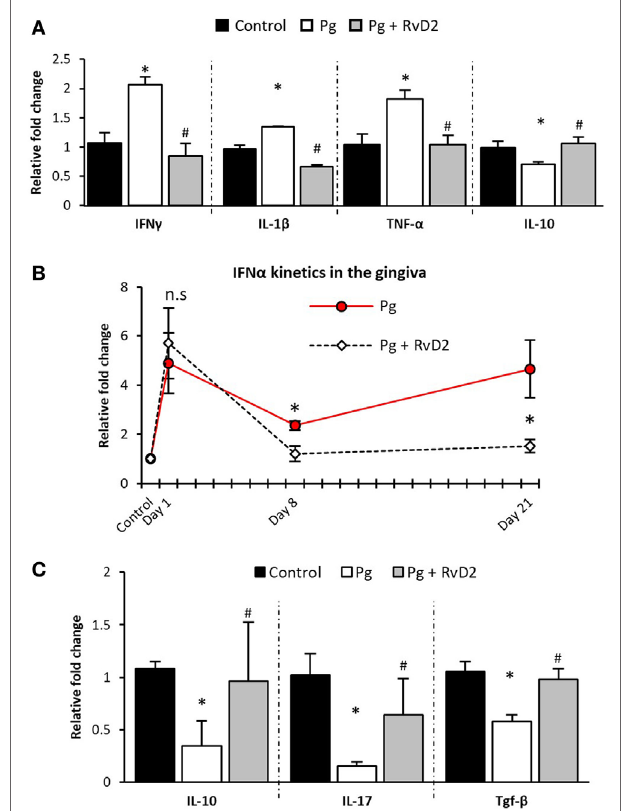
FigUre 4 | Resolvin D2 dampens neutrophil recruitment to the gingiva . Three days after the last exposure, (a) blood cells and (B) gingival tissues were analyzed by flow cytometry. Data represent the mean of five mice per group ± SEM of three independent experiments. (c) Gingival macrophages were FACS sorted (CD45 + , F4/80 + , I-A d + ), and processed with lysis buffer for protein extraction, after protein quantification, 30 µg per sample were immunoblotted against IRF4, IRF5, and β -actin. The blot is representative of three pooled samples of two independent experiments. (D) IRF4 and IRF5 protein relative density (gene/actin) of gingival isolated macrophages, * p < 0.05 relative to control group. # p < 0.05 relative to Pg